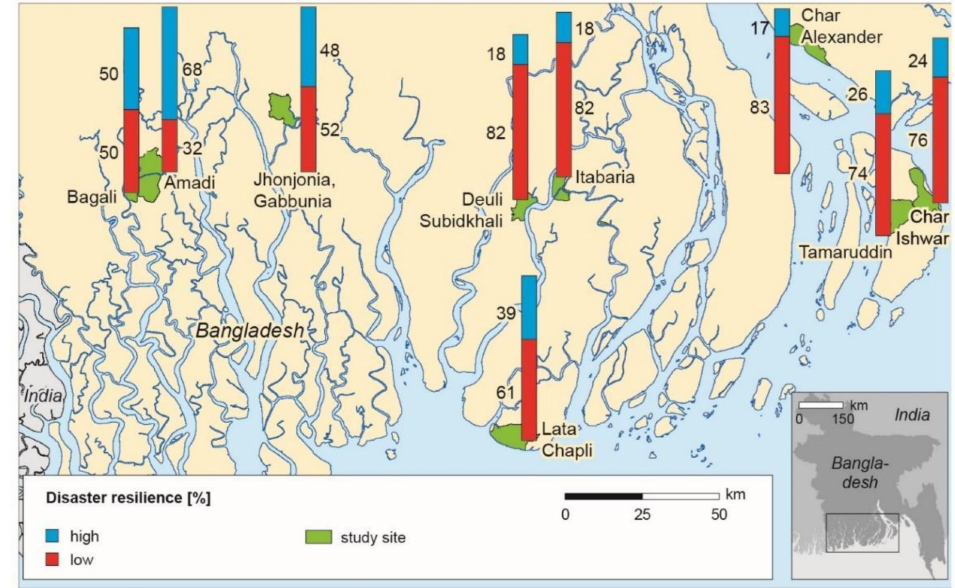
Figure 3. Level of household disaster resilience in study villages. Source: Own design Abdullah Al-Maruf; cartography Ulrike